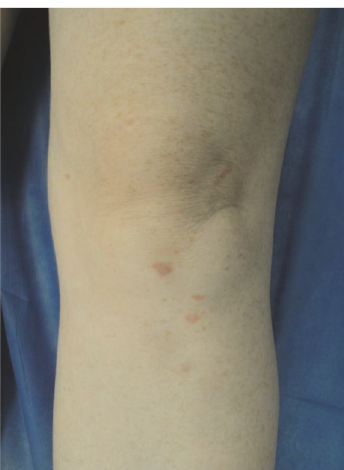
Figure 1: Clinical photograph showing numerous erythematous-to-brown papules on the anterior left knee.